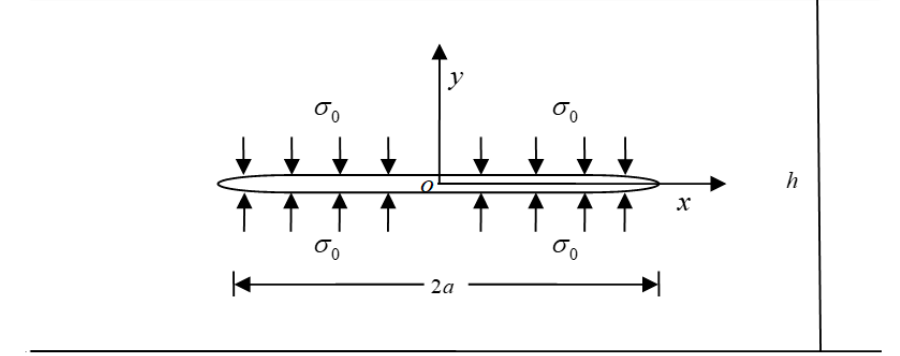
Figure 2. A decagonal quasicrystalline strip with a centric crack.